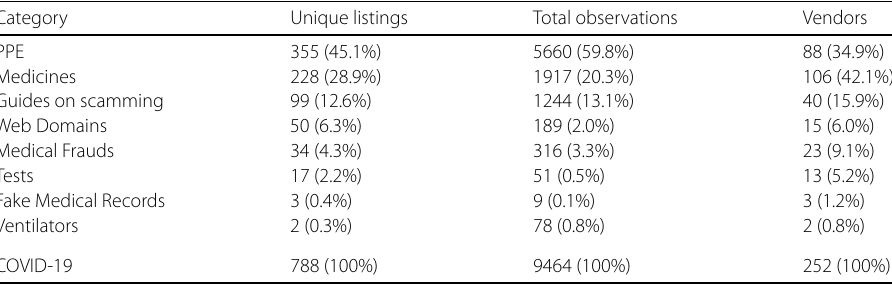
Table 3 Summary statistics for the considered categories of listings. For each category, we included the number of unique listings, observations, and vendors. If the same vendor sold listings in different categories, we counted it as one unique vendor Category Unique listings Total observations Vendors PPE 355